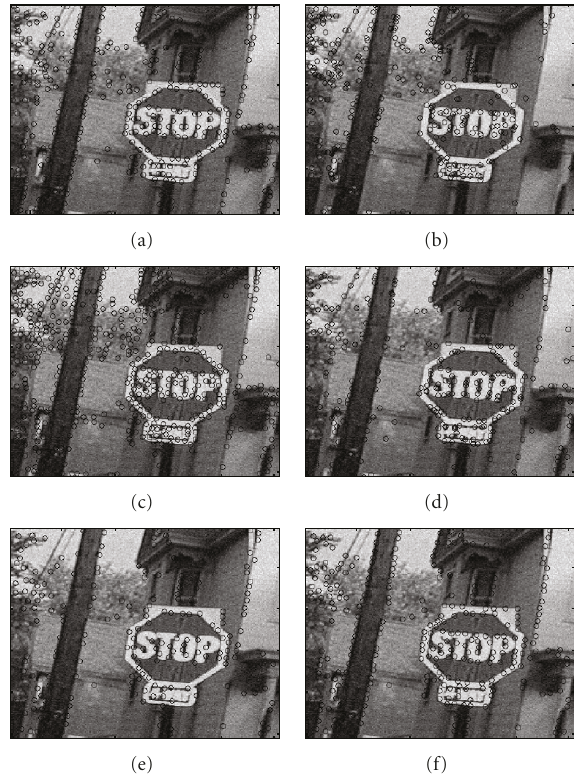
Figure 12: (a) Feature points detected in noisy image with SNR = 25 dB by (a) Harris method (b) Lowe’s method, (c) Tomasi’s method, (d) Loupias’s technique, (e) Yeh’s algorithm, and (f) proposed